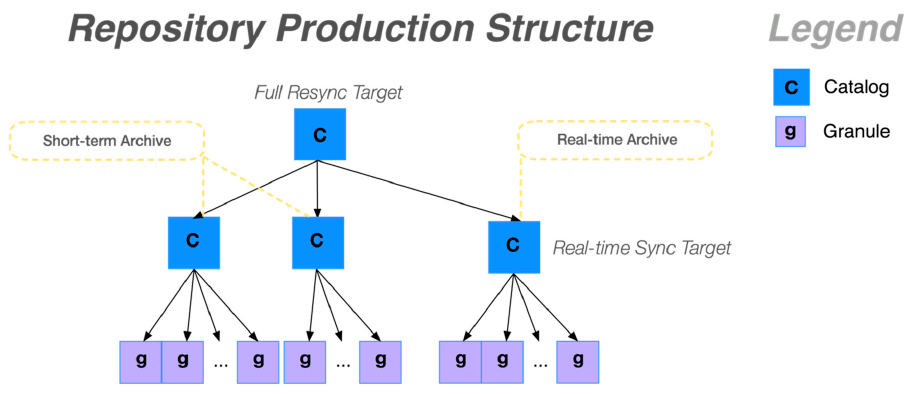
Figure 5. Repository metadata production model.